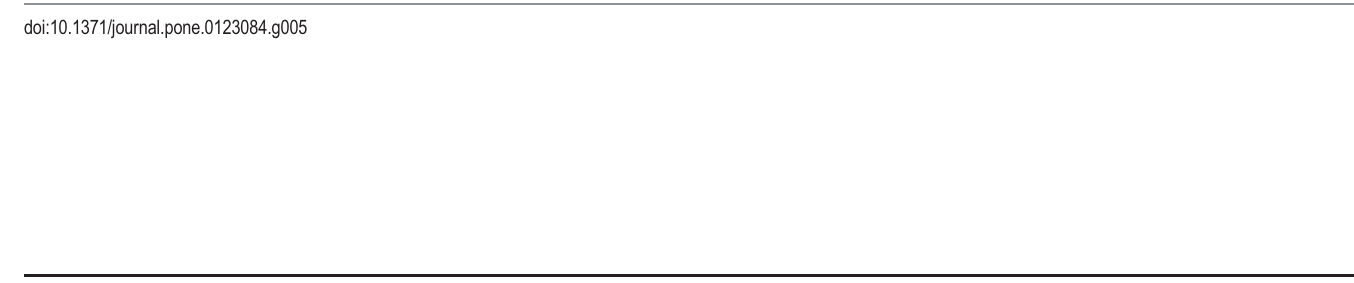
PLOS ONE | DOI:10.1371/journal.pone.0123084 April 30,